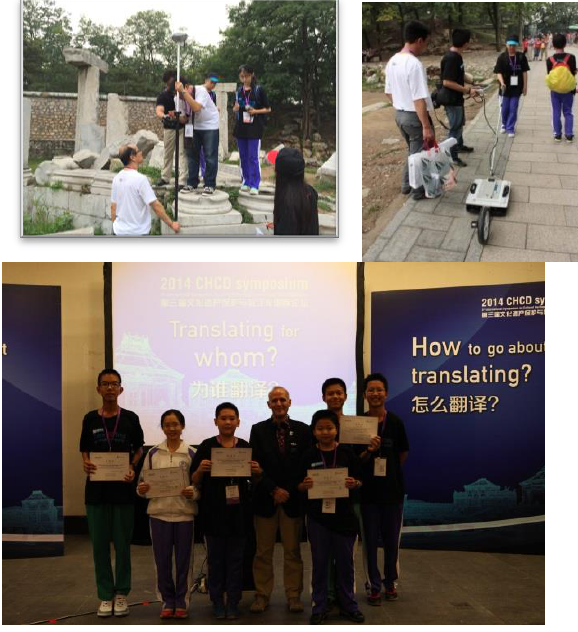
Figure 8. Students participating CHCD